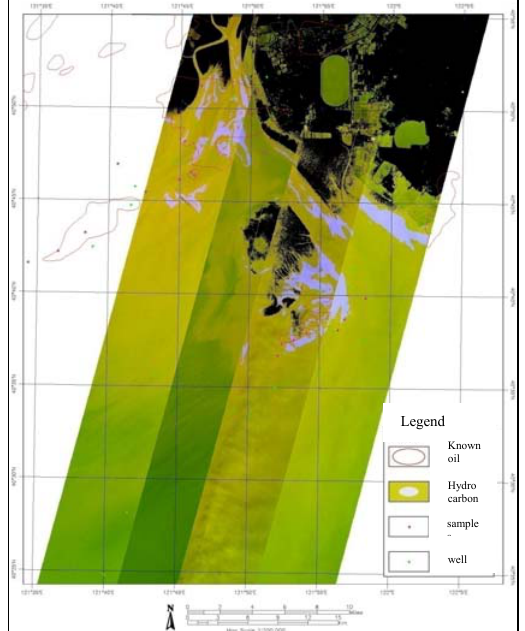
Figure 6. Hydrocarbon information extracted from Hyperion image by